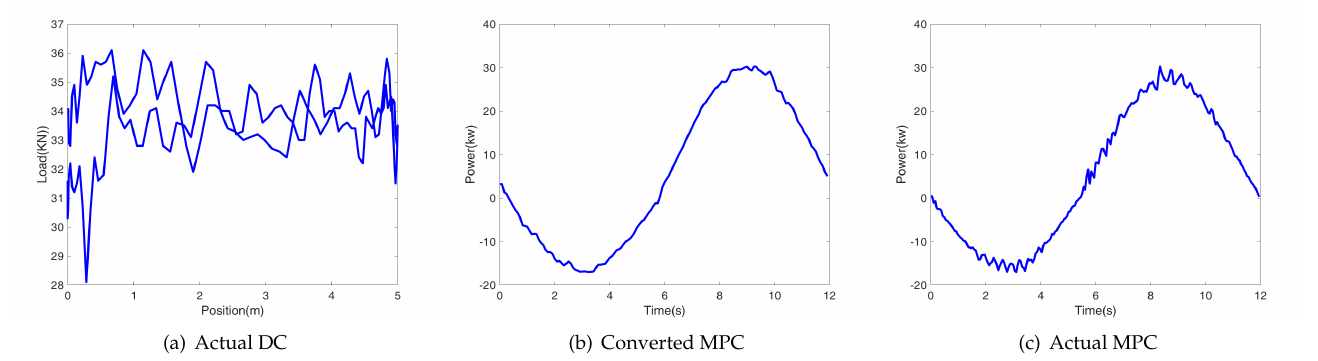
Figure 10. Gas locking working state.